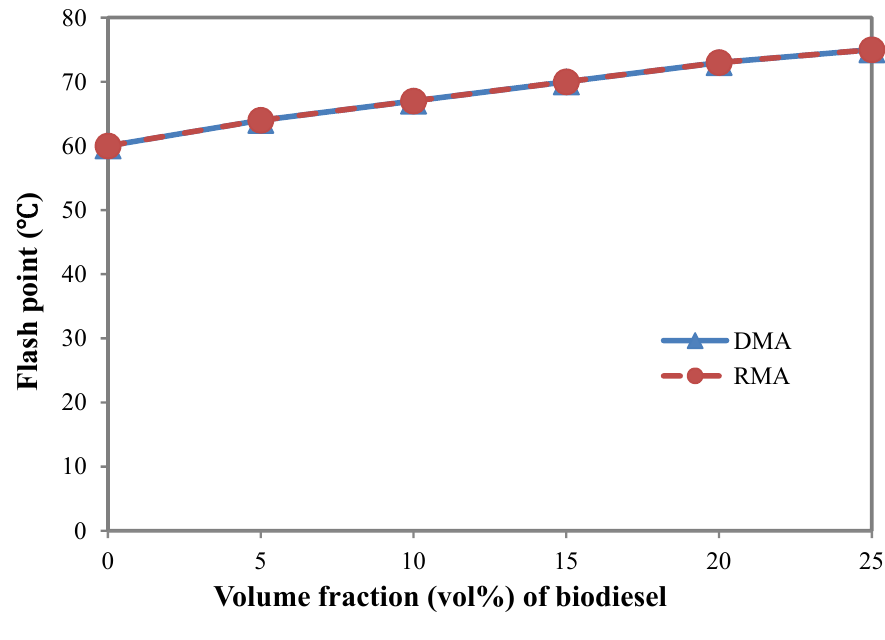
Figure 1. Variation of flash point with volume fraction of biodiesel blends in distillate marine fuel DMA and residual marine fuel